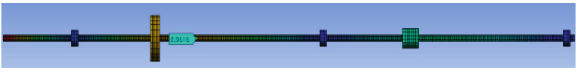
Figure 5: Harmonic response mode of our flexible shafting.